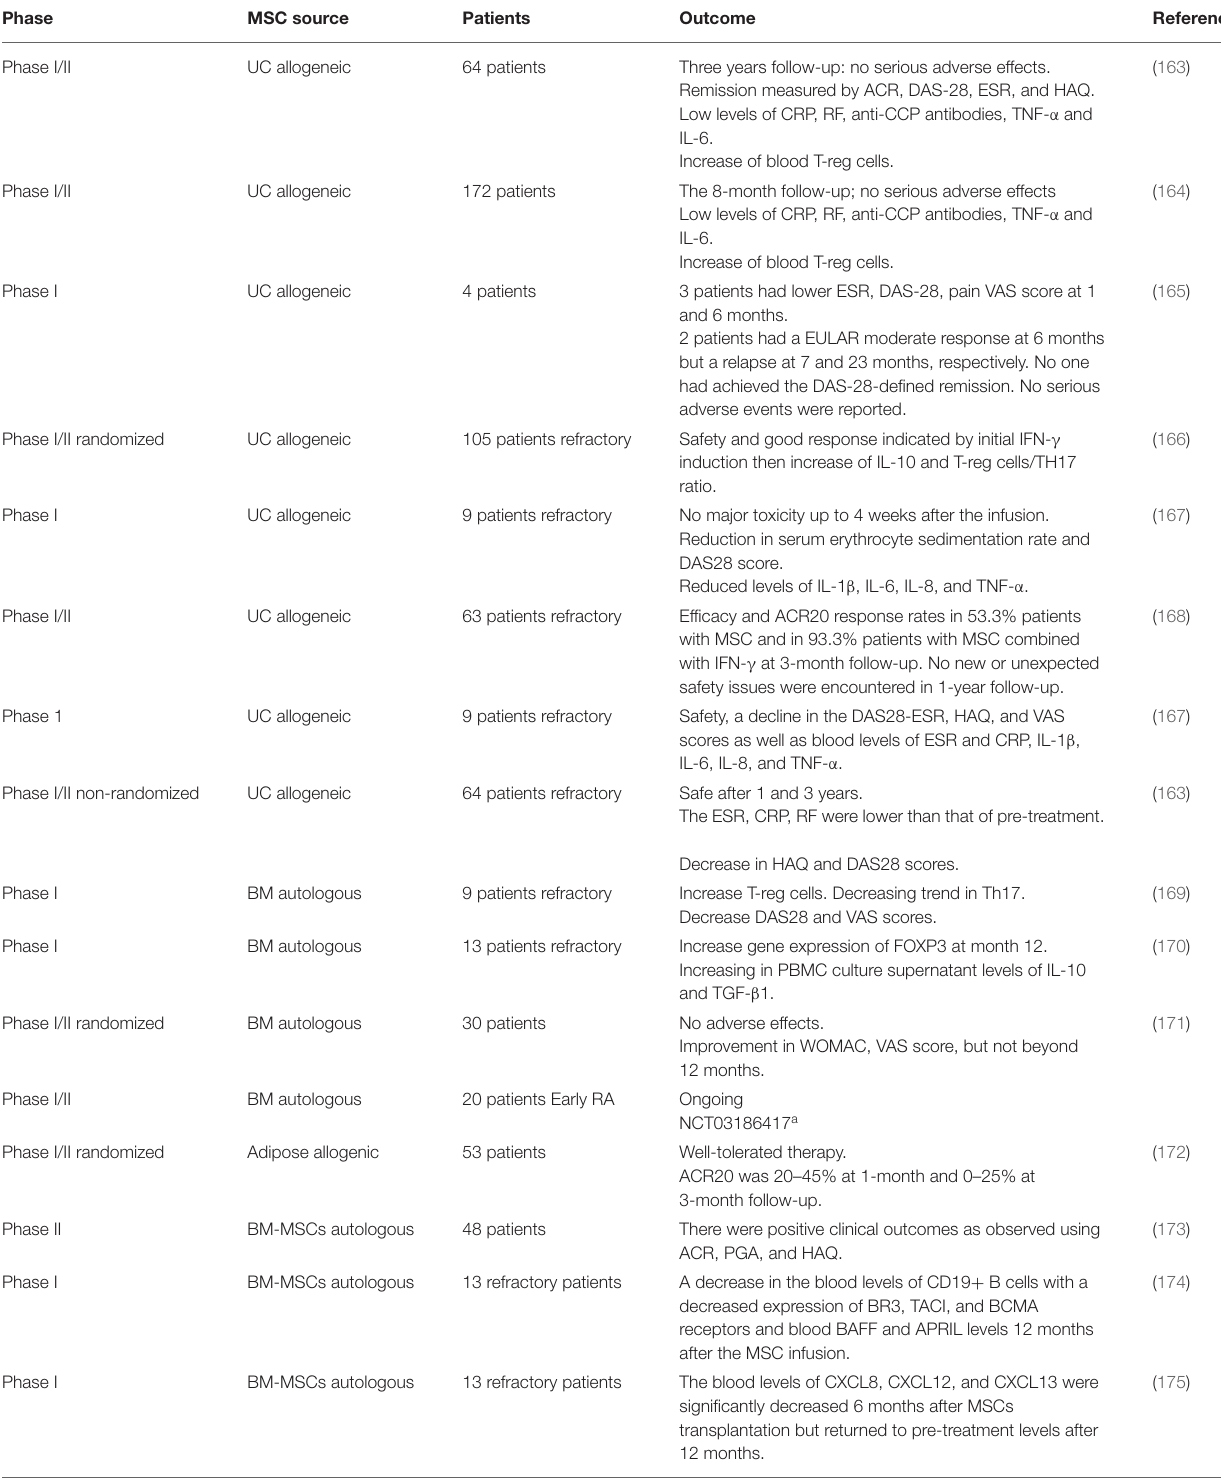
TABLE 1 | Clinical trials for RA therapy using